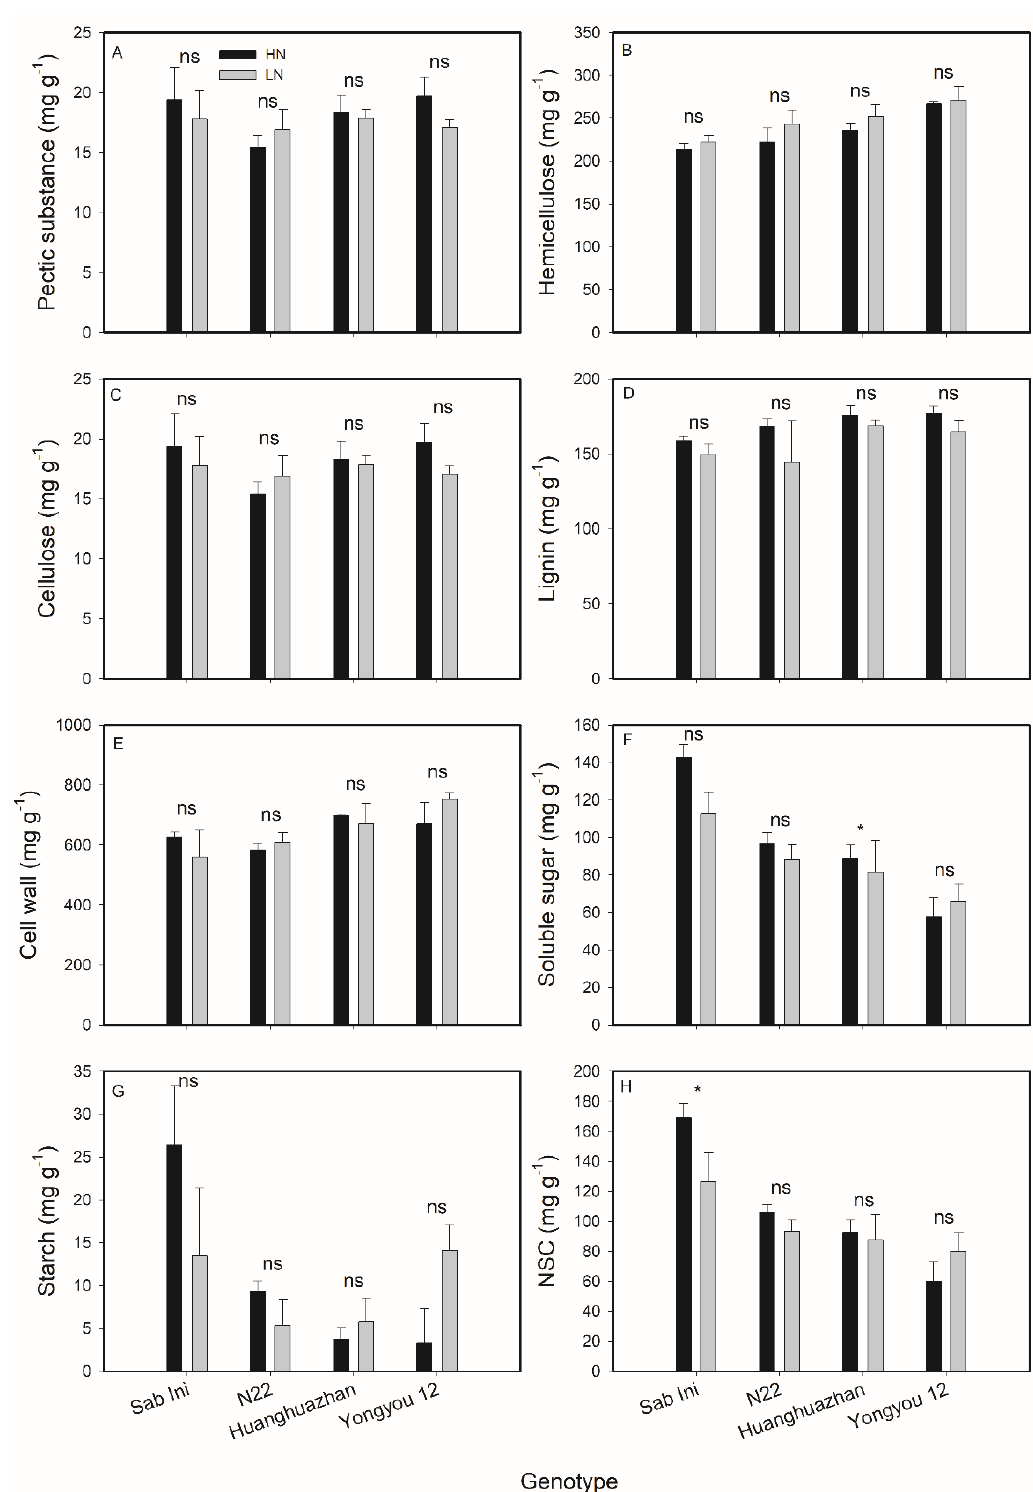
Figure 4. Variations in mass-based pectic substances content ( A ), hemicellulose content ( B ), cellulose content ( C ), lignin content ( D ), cell wall content ( E ), soluble sugar content ( F ), starch content ( G ) and non-structural carbohydrates (NSC) content ( H ) in the flag leaves of the four rice genotypes between high (HN) and low (LN) nitrogen supply. Parameters were compared between HN and LN for each genotype based on the least significant difference (LSD) test at the 0.05 probability level. *, p < 0.05; ns, non-significant.